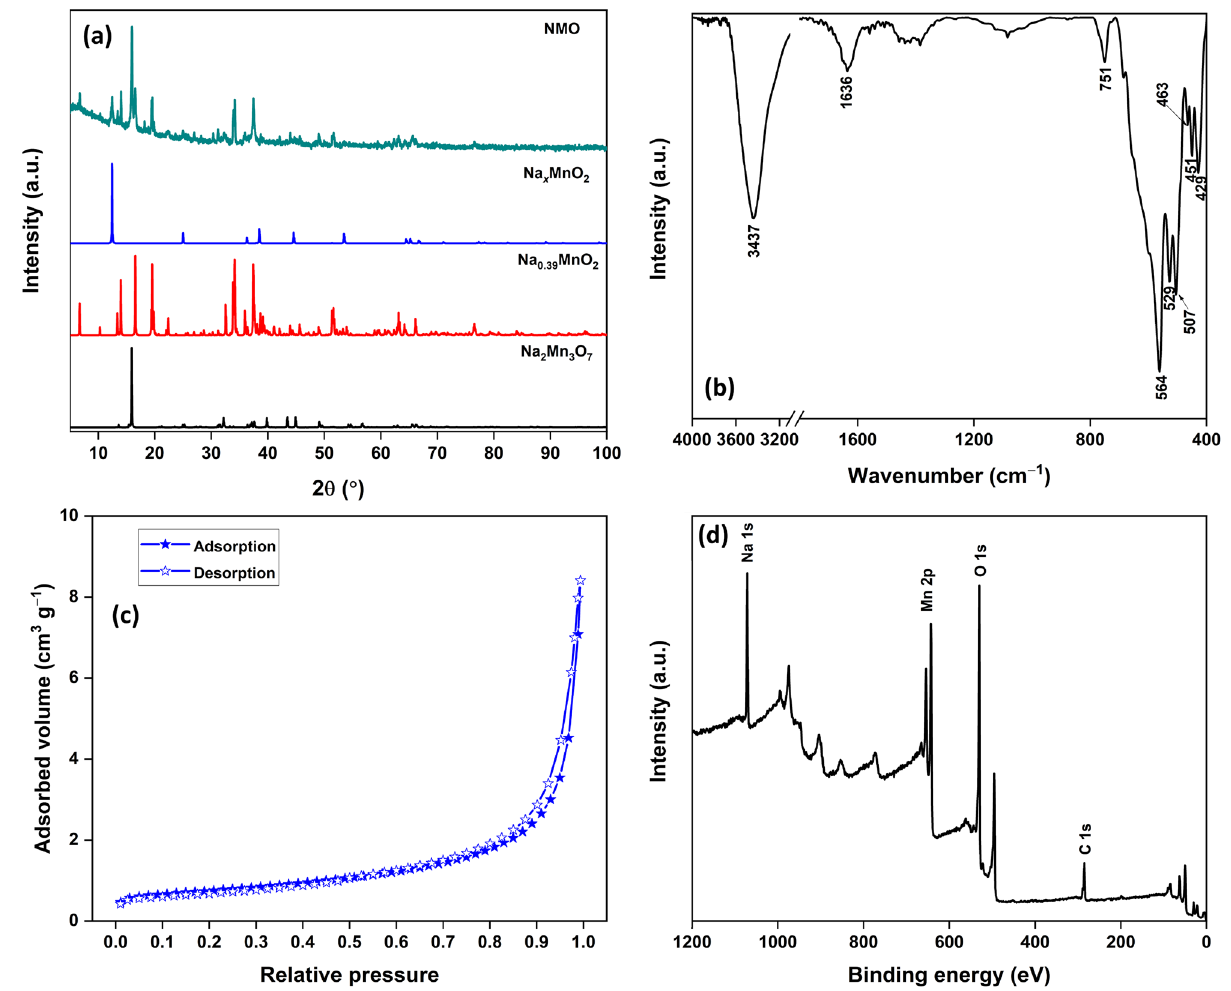
Figure 2. ( a ) PXRD pattern; ( b ) FTIR spectrum; ( c ) N 2 adsorption–desorption isotherm; ( d ) XPS survey of